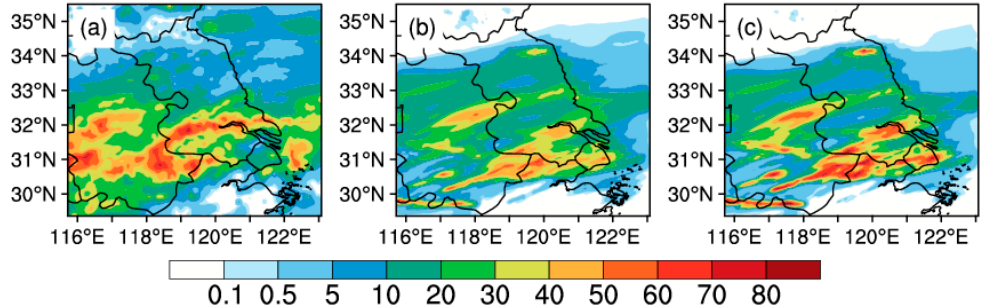
Figure 8. 2-h accumulated precipitation distribution for 0000 UTC to 1200 UTC on 12 July 2014 (unit: mm); ( a ) observation, ( b ) EM, and ( c ) PM mean.